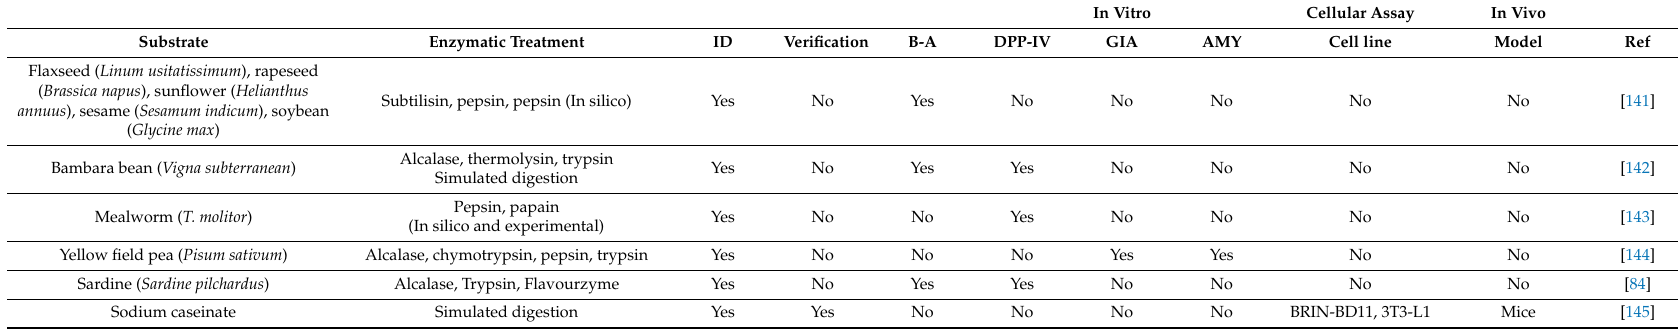
In Vitro Cellular